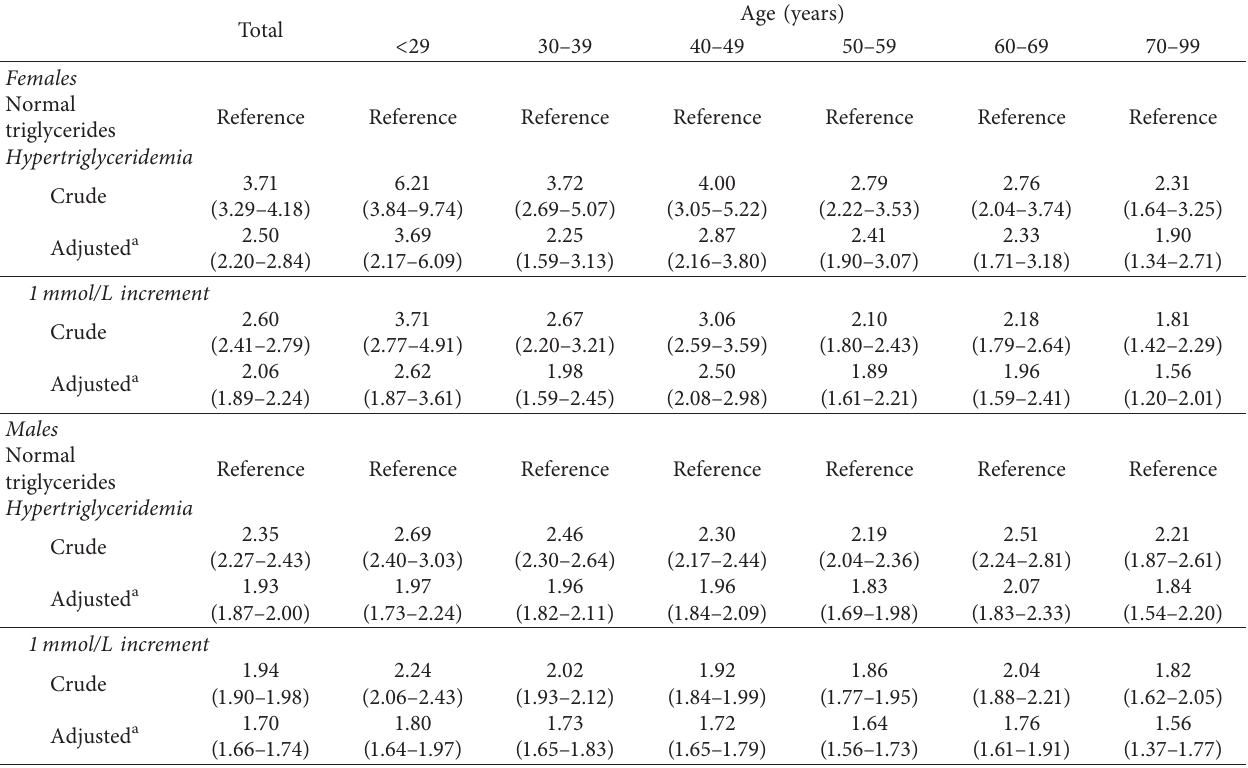
Table 4: The OR (95% confidence interval) of serum urate > 420 μ mol/L according to normal triglycerides and hypertriglyceridemia.